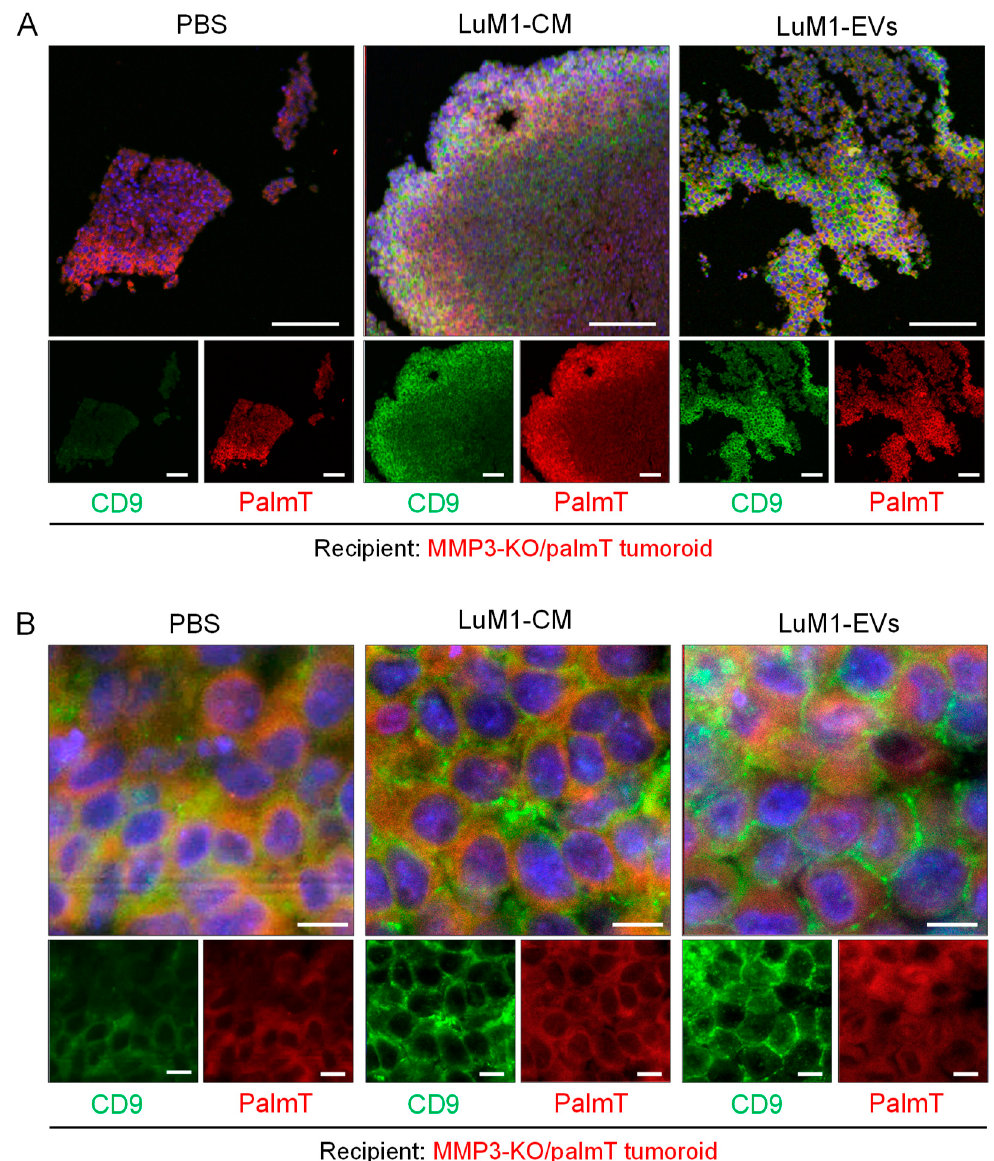
Figure 9. Treatment with LuM1-derived EVs and CM recovered CD9 in MMP3-null tumoroids. MMP3-KO / palmT (red) tumoroids were treated with PBS, LuM1-CM, or LuM1-EVs for 24 h in the ULA-based 3D culture system. CD9 (green) was stained by immunofluorescence. Nuclei were stained blue with DAPI. Images were taken by CLSM. ( A ) low and ( B ) high magnifications were shown. Top images, merge of three color. Scale bars; 100 µ m (in low magnification images) and 10 µ m (in high magnification images).